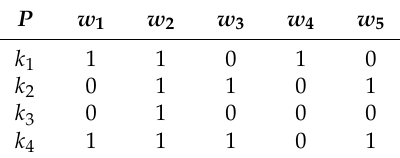
Table 1. Crisp soft relation P